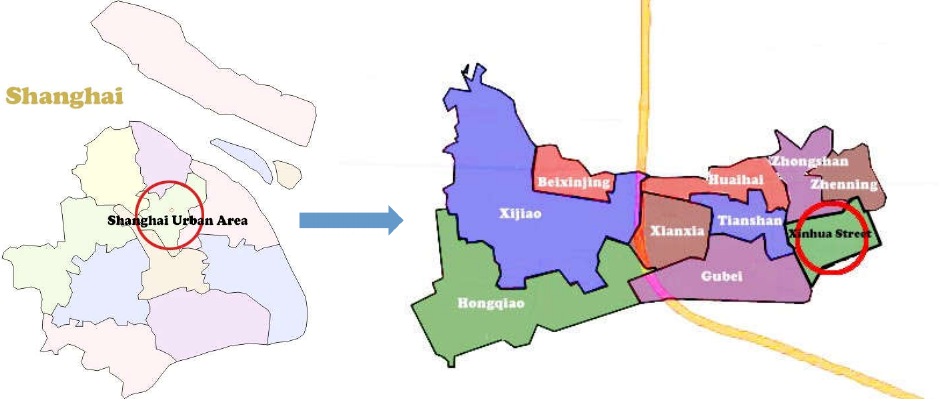
Figure 1. Location of Xinhua Street.